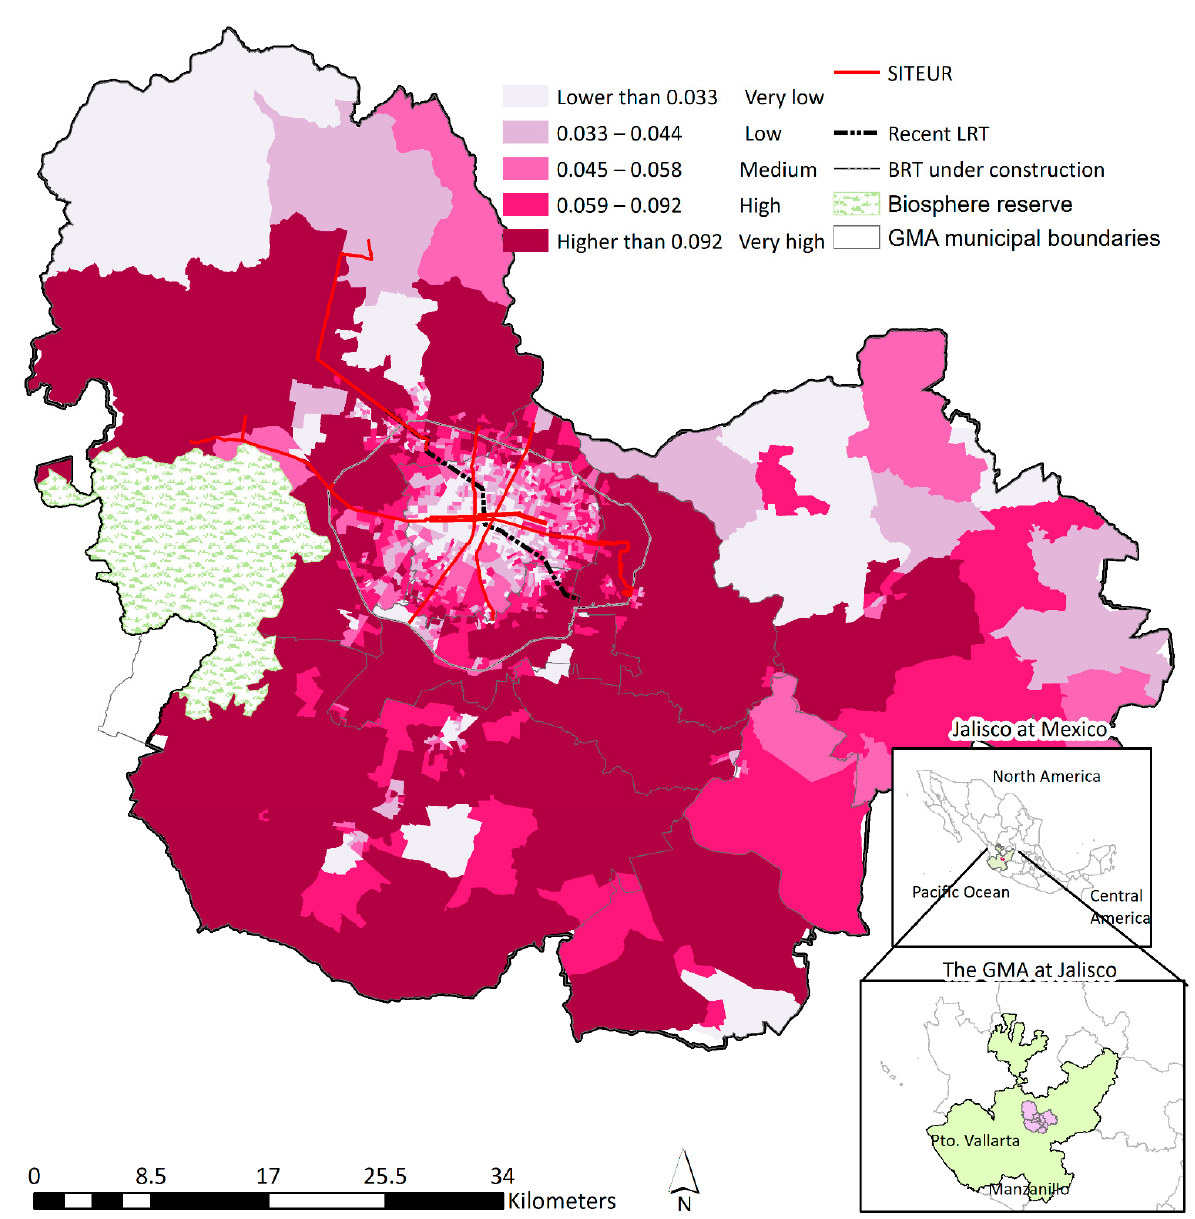
Figure 5. Index of Social Transport Needs. Source: Authors, based on [42,43,45–50].